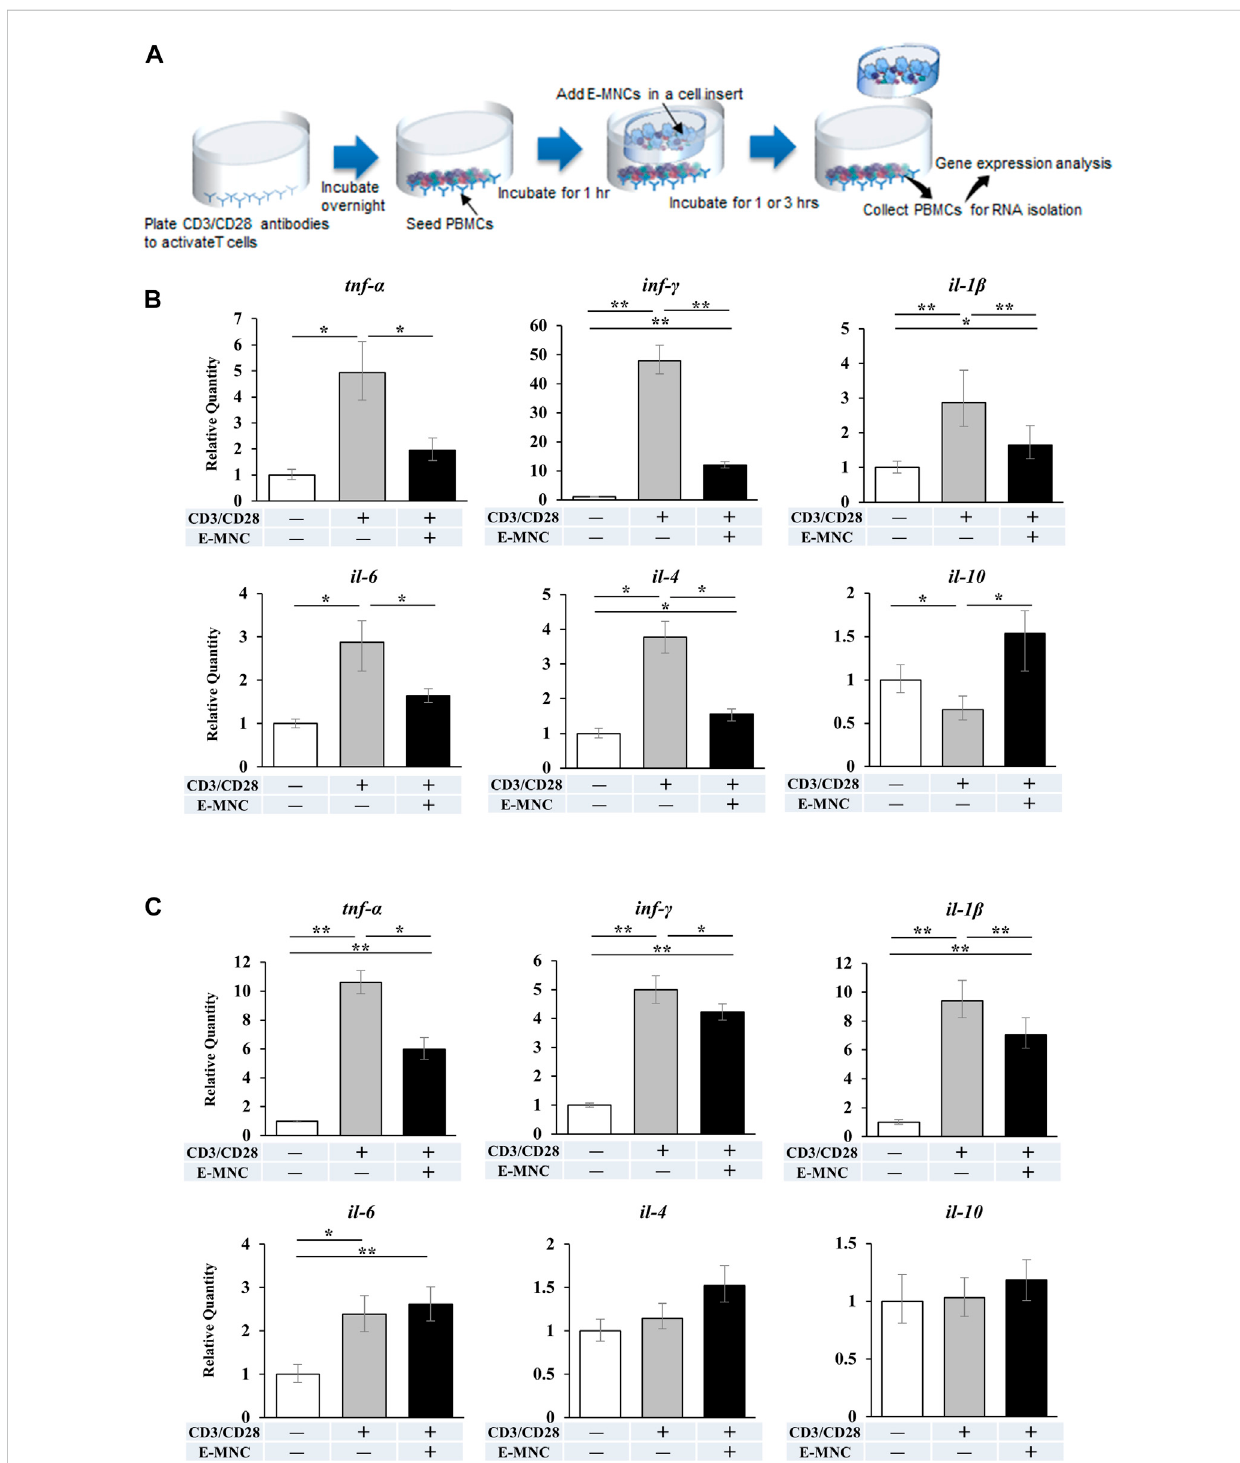
FIGURE 4 mRNA expression in CD3/CD28-stimulated PBMNCs after co-culture with E-MNCs. (A) Schematic diagram describing the experimental design for co-culture of E-MNCs and T-cell – activated PBMNCs. Anti-CD3 and -CD28 antibodies were added to the wells of a 24-well plate and incubated overnight. PBMNCs were then seeded in the wells and cultured at 37 ° C for 1 h. Subsequently, E-MNCs were seeded in the upper chamber and co- cultured with stimulated PBMNCs for 1 or 3 h (B and C) mRNA expression of tnf- α , ifn- γ , il-1 β , il-6 , il-4 , and il-10 in PBMNCs and CD3/CD28- stimulated PBMNCs with/without E-MNCs for 1 h (B) or 3 h (C) (* p < 0.05, ** p < 0.01). For statistical analysis, one-way ANOVA with post hoc Tukey ’ s multiple comparisons were performed for multiple